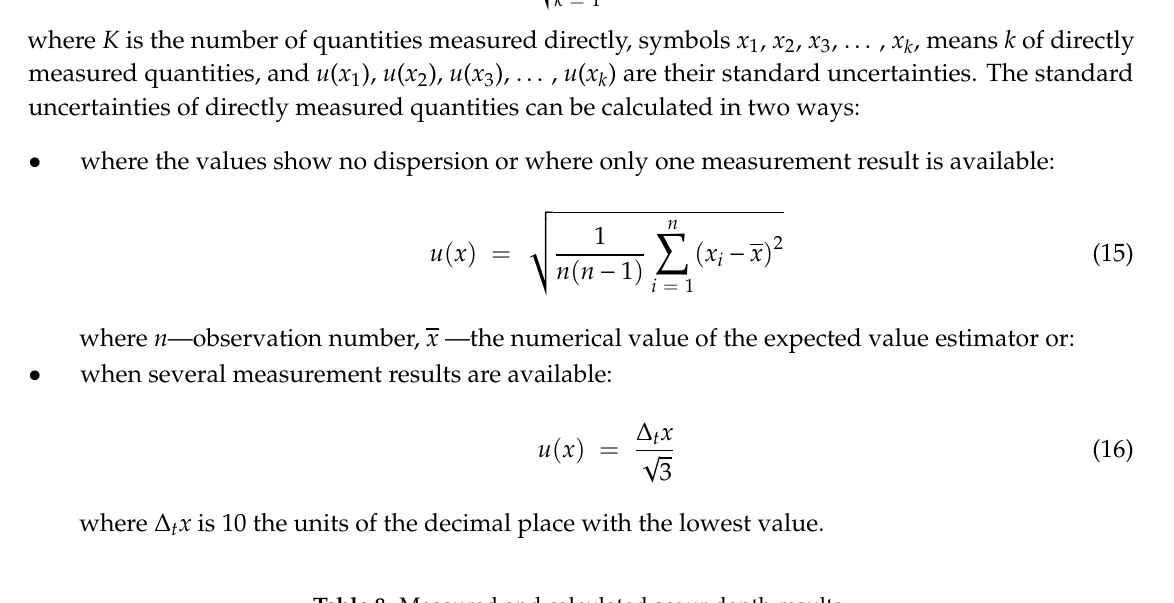
Table 8. Measured and calculated scour depth